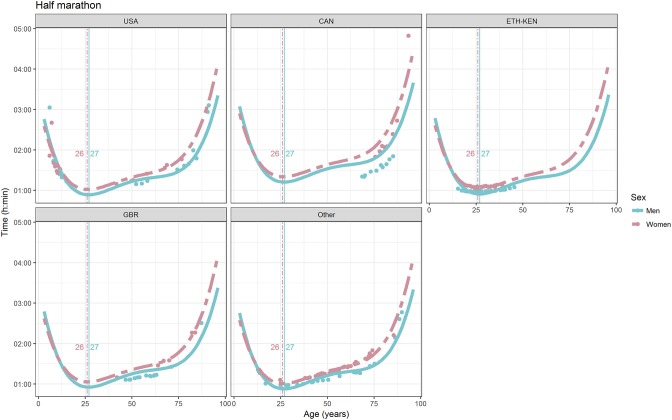
World record in half-marathon by sex, age (in years), and country. Points were observations. Curves represented quartic degree polynomial regression. Vertical lines with numeric labels were the ages at peak performance.